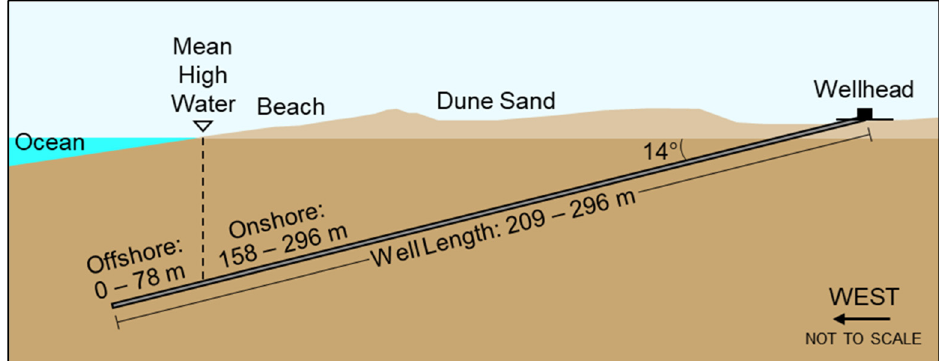
Figure 9. Proposed slant well profile with onshore and offshore well lengths (adapted from [36]).